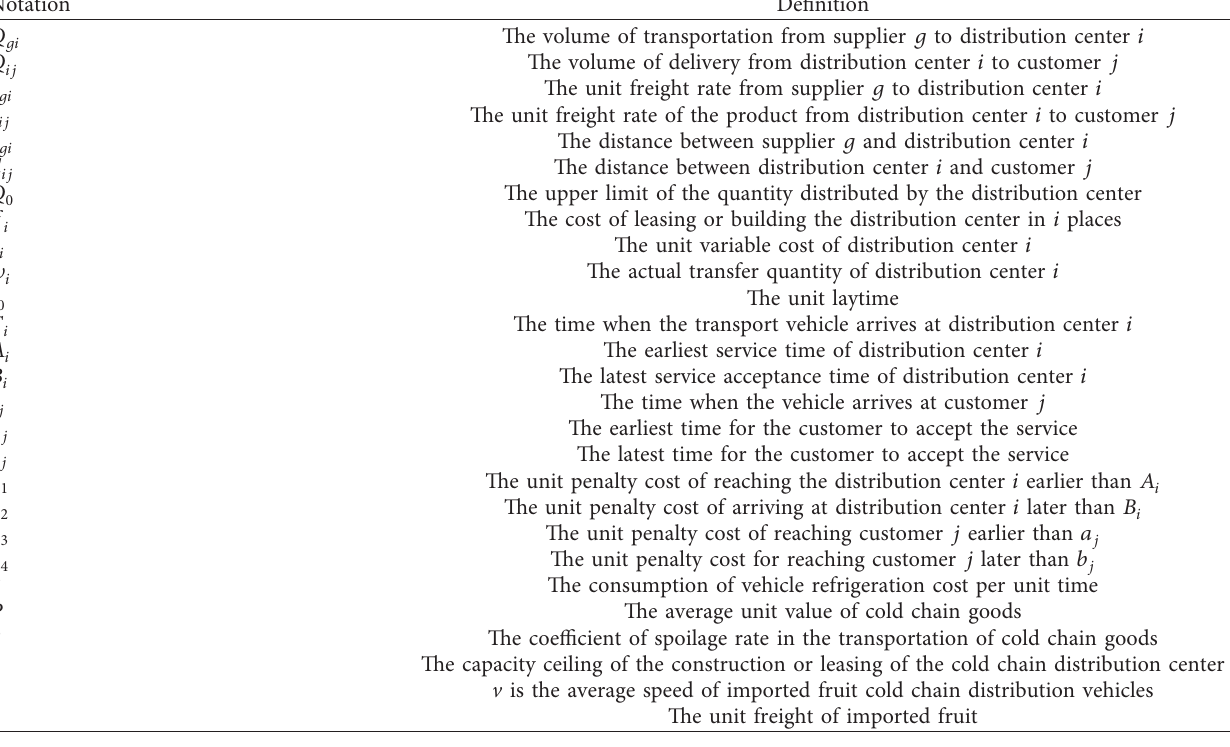
Table 2: Notation for the